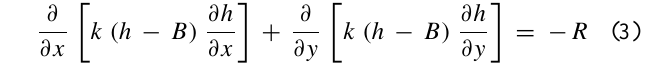
Fig. 3. Streams, river channels, and low conductivity zone.